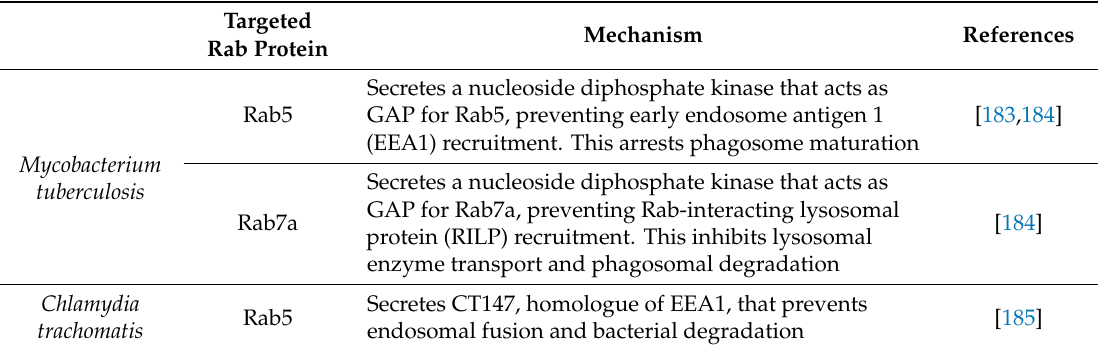
Table 3. Intracellular bacteria that target Rab